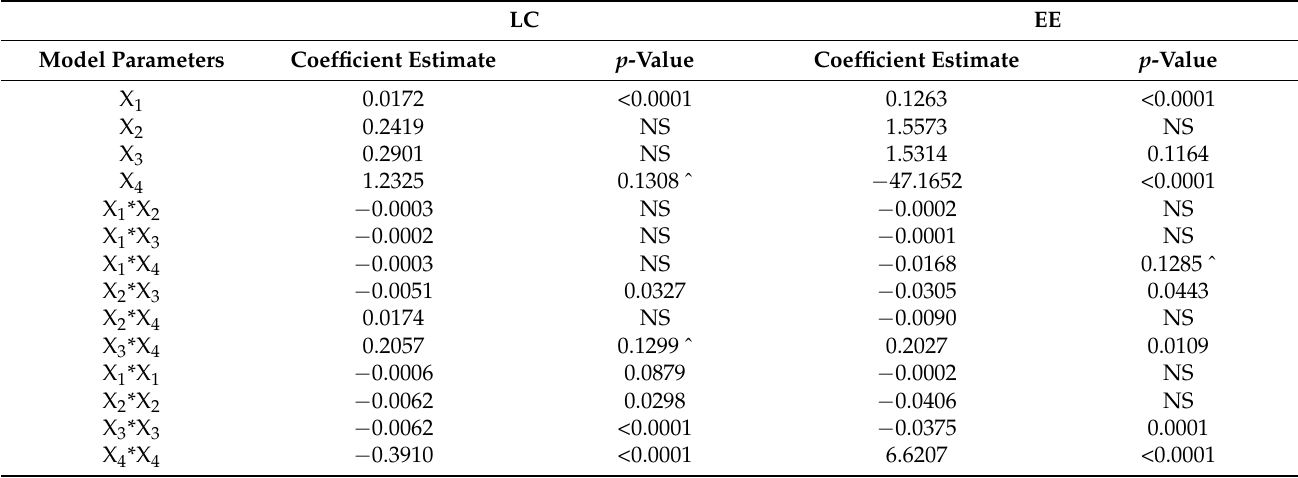
Table 4. Model parameter coefficients (and their associated p -value between brackets) for the prediction of the LC and EE of curcumin. Coefficients have to be used with coded levels for each